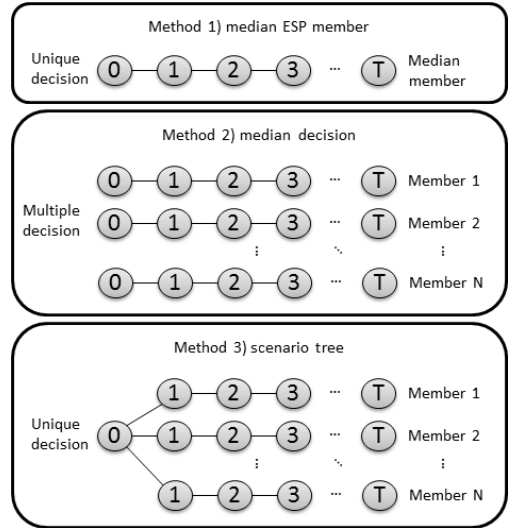
Figure 5. Overview of the three optimization algorithms and their decision